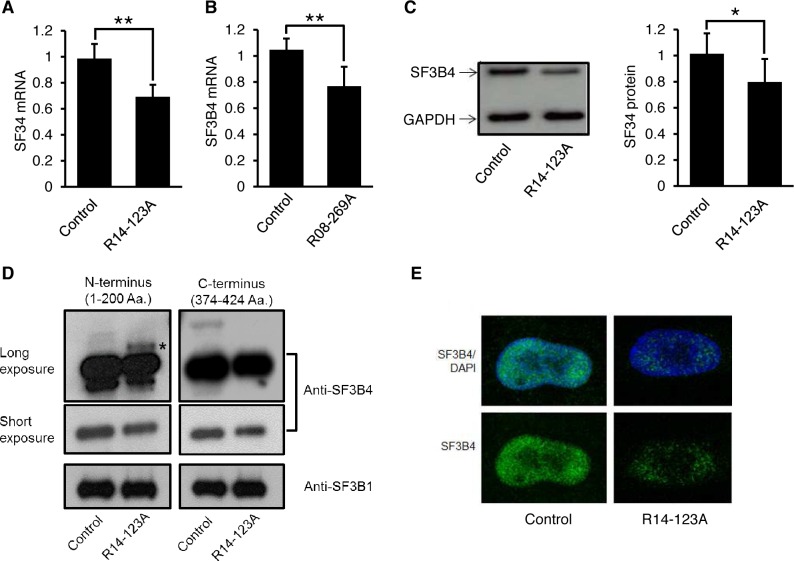
Decreased expression of SF3B4 in Rodriguez syndrome.(A,B) Detection of SF3B4 mRNA by quantitative RT-PCR in (A) R14-123A fibroblasts and (B) R08-269A chondrocytes. (C) Western blots (left panel) and signal quantification (right panel) of SF3B4 in R14-123A fibroblasts. Data in the bar graphs were collected from at least three replicates and were represented as mean ± standard deviation. *p<0.05; **p<0.01. (D) Detection of SF3B4 protein in R14-123A fibroblasts by Western blotting with the antibodies against the N- and C-termini of the SF3B4 protein, respectively. The asterisk identifies the elongated form of SF3B4 that was presumed to be derived from the mutant allele. SF3B1 protein was used as a loading control. (E) Immunostaining of human fibroblasts with anti-SF3B4 (green). Cell nuclei were stained with DAPI (blue).